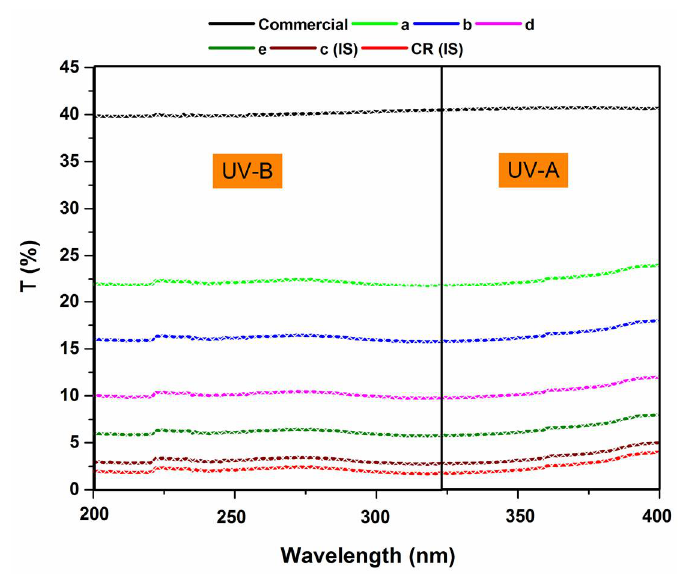
Figure 9. UV transmission spectra of commercial and prepared nanofiber samples.